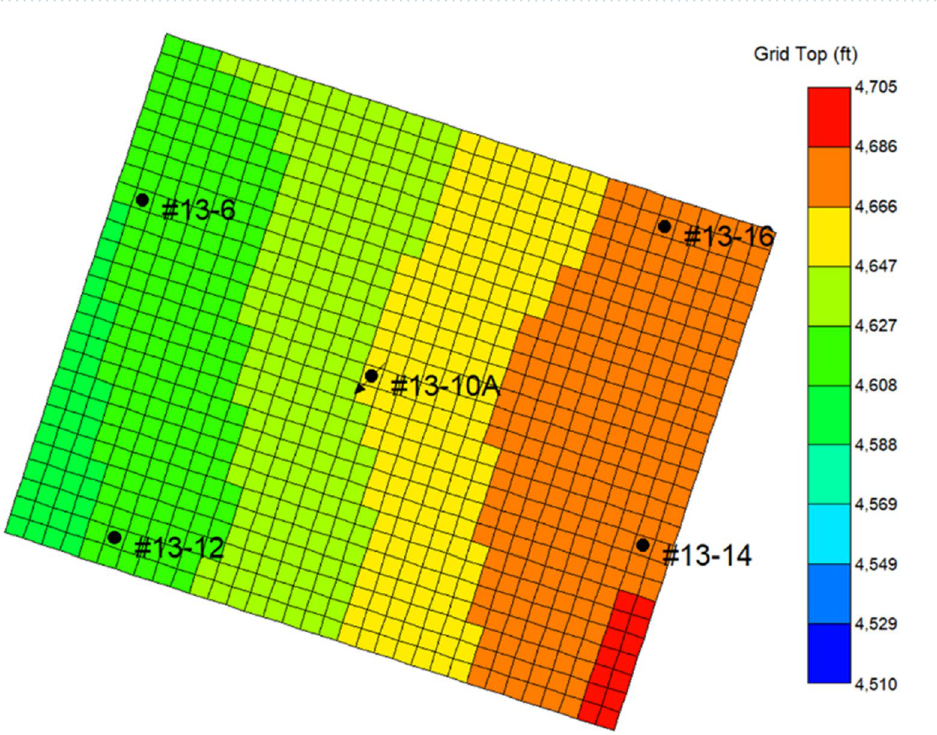
Figure 3. 3D view of the 13-10A inverted 5-spot pattern consisting of the Morrow B sandstone and the upper Morrow shale. Layer 1 is the top layer of the caprock and numbers increase with depth through to Layer 9 indicated as the bottom layer of the reservoir.